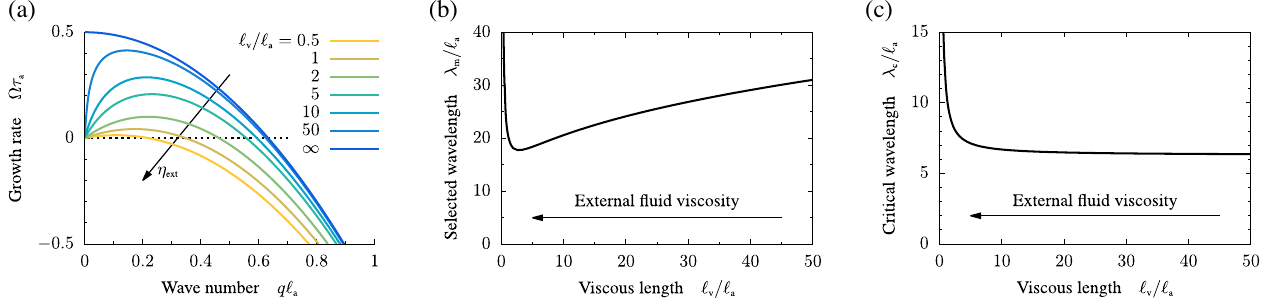
FIG. 7. Vortex size selection. (a) Growth rate [Eq. (C13)] along the most unstable direction for the spontaneous-flow instability in an active nematic film coupled to an external fluid layer. The viscosity ratio is set to r ¼ γ = η n ¼ 1 , and flow alignment is ignored. The different curves correspond to different values of the external fluid viscosity η , expressed in terms of the viscous length l v ¼ η n = η . ext ext The blue line corresponds to an isolated active nematic film, without external fluid. Lengths and time are rescaled by the active length and time, l a and τ a defined in Eq. (C12). (b) Wavelength at which the growth rate is maximum, as obtained from Eq. (C14), as a function of the viscous length. This wavelength is selected by the linear dynamics upon the spontaneous-flow instability. (c) Critical wavelength of the spontaneous-flow instability [Eq. (C15)] as a function of the viscous